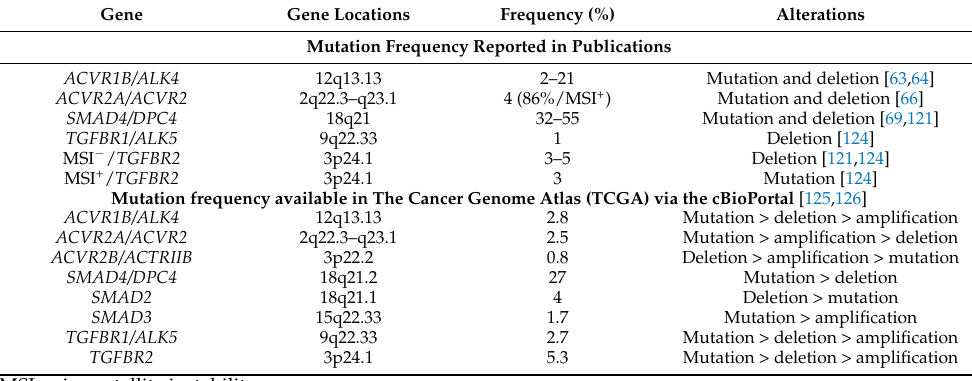
Table 2. Genomic alterations of the activin/TGF β signaling axes in PDAC.